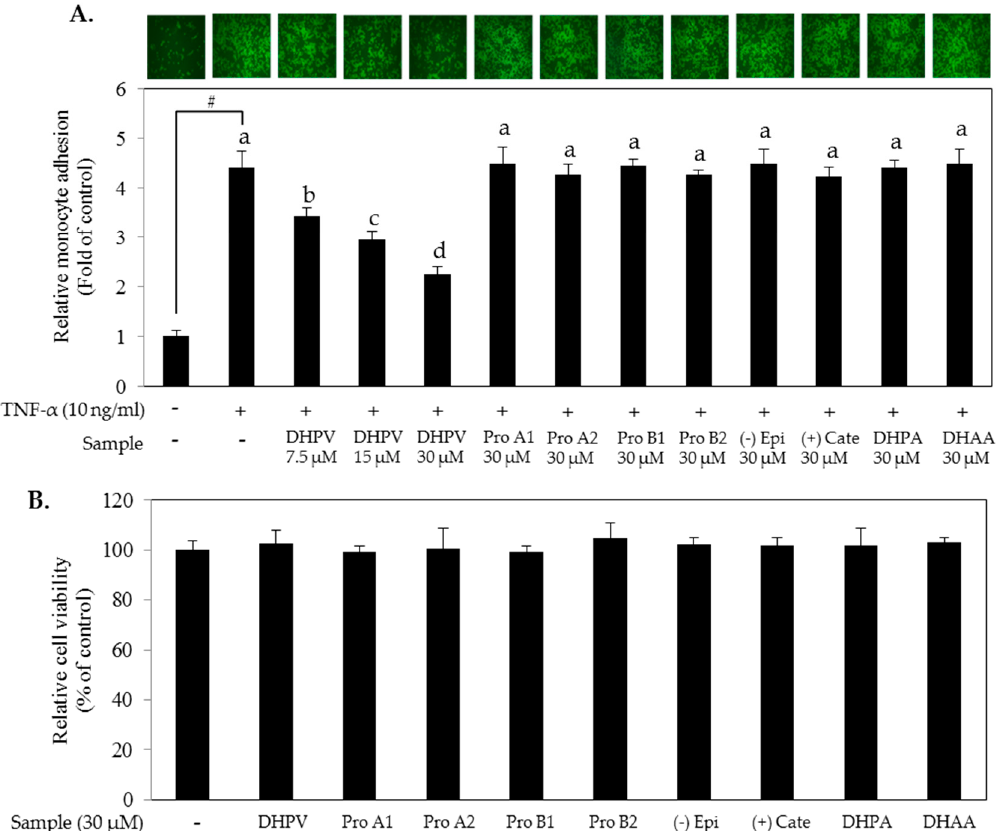
Figure 2. Comparison of monocyte-endothelial adhesion inhibitory effects between DHPV and other procyanidins and their microbial metabolites. ( A ) Following pretreatment of procyanidin derivatives at the indicated concentrations for 1 h, human umbilical vein endothelial cells (HUVECs) were exposed to tumor necrosis factor (TNF)- α for a further 5 h. Calcein AM-labeled THP-1 human monocytic cells were then added to the HUVEC medium and for 1 h to allow for adherence. The number of adhered THP-1 cells was determined with a fluorescence microplate reader at excitation and emission wavelengths of 485 and 535 nm, respectively. Images were captured with a fluorescence microscope. ( B ) Varying concentrations of DHPV and 30 µM of various procyanidins and their microbial metabolites were tested for cytotoxicity. Data are expressed as means ± SD ( n = 4). # p < 0.05 versus control. Different letters (a, b, c and d) denote significant differences ( p < 0.05); values bearing the same letters are not significantly different from each other. Pro A1, procyanidin A1; Pro A2, procyanidin A2; Pro B1, procyanidin B1; Pro B2, procyanidin B2; ( − ) Epi, ( − ) epicatechin; (+) Cate, (+) catechin; DHPA, 3-(3 ′ ,4 ′ -dihydroxyphenyl)-propionic acid; DHAA, 3,4-dihydroxyphenyl-acetic acid.